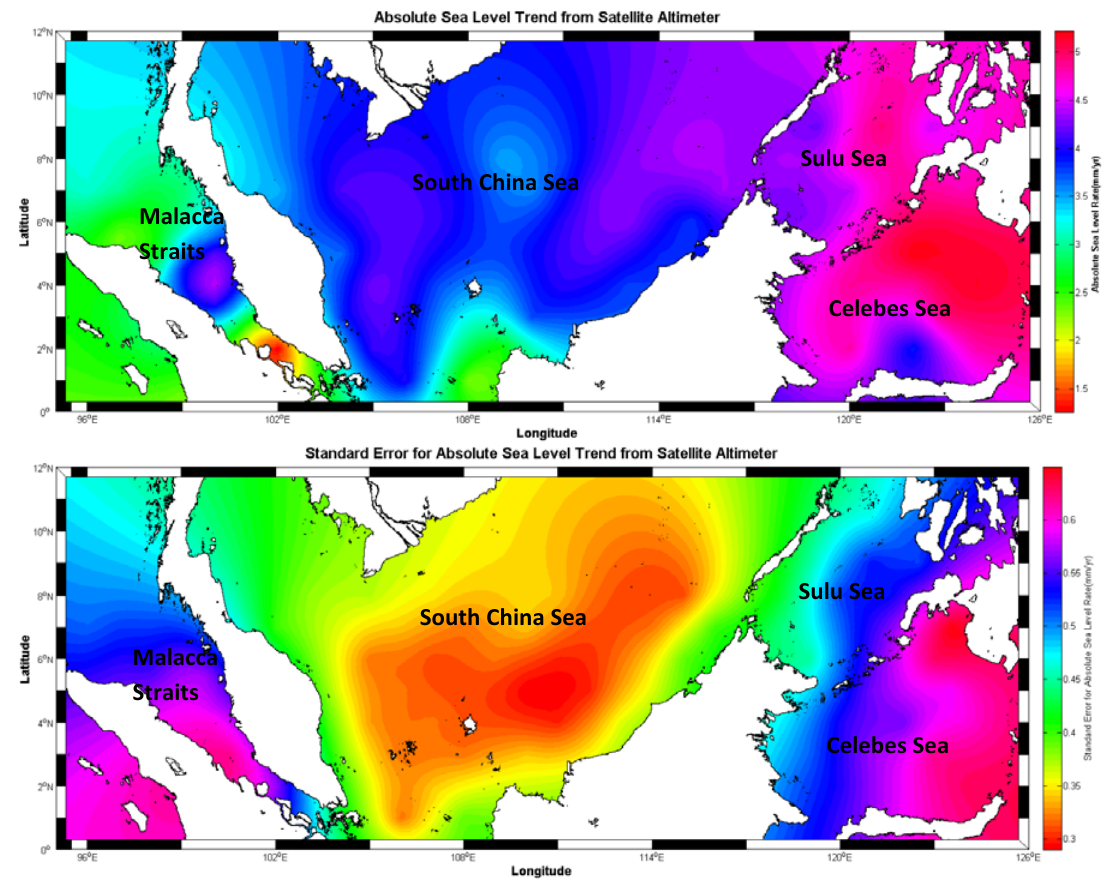
Figure 11. Map of absolute sea level trend ( upper ) and its standard error ( lower ) over the Malaysian Seas The sea level rise at 3.85 ± 0.05 mm yr - 1 in the South